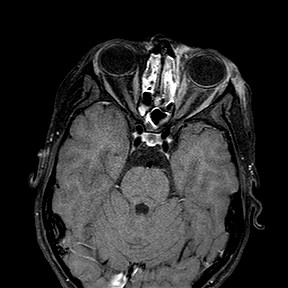
Axial contrast-enhanced fat suppressed T1-weighted MR. The image demonstrates ethmoid and sphenoid sinusitis and an heterogeneous enhancement of left eyelid tissues and of orbital fat. The left orbital extraocular muscles show a moderate enhancement due to edema and hyperaemia. Left medial rectus muscle is also moderately thickened.